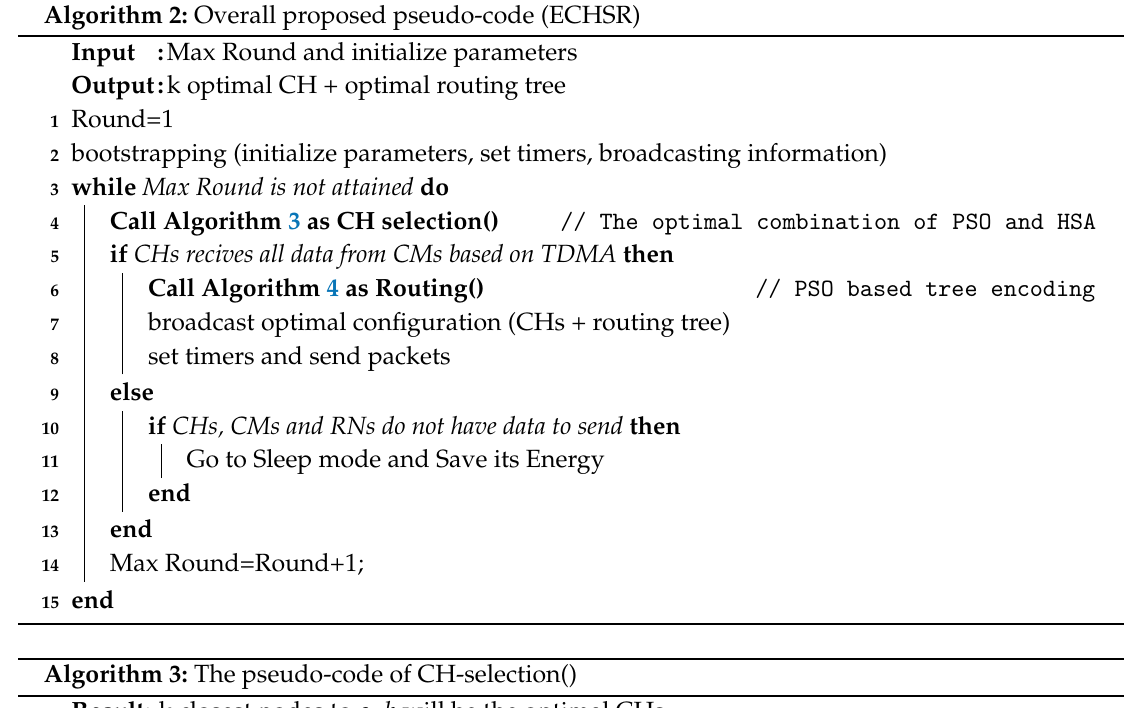
Algorithm 2: Overall proposed pseudo-code (ECHSR)